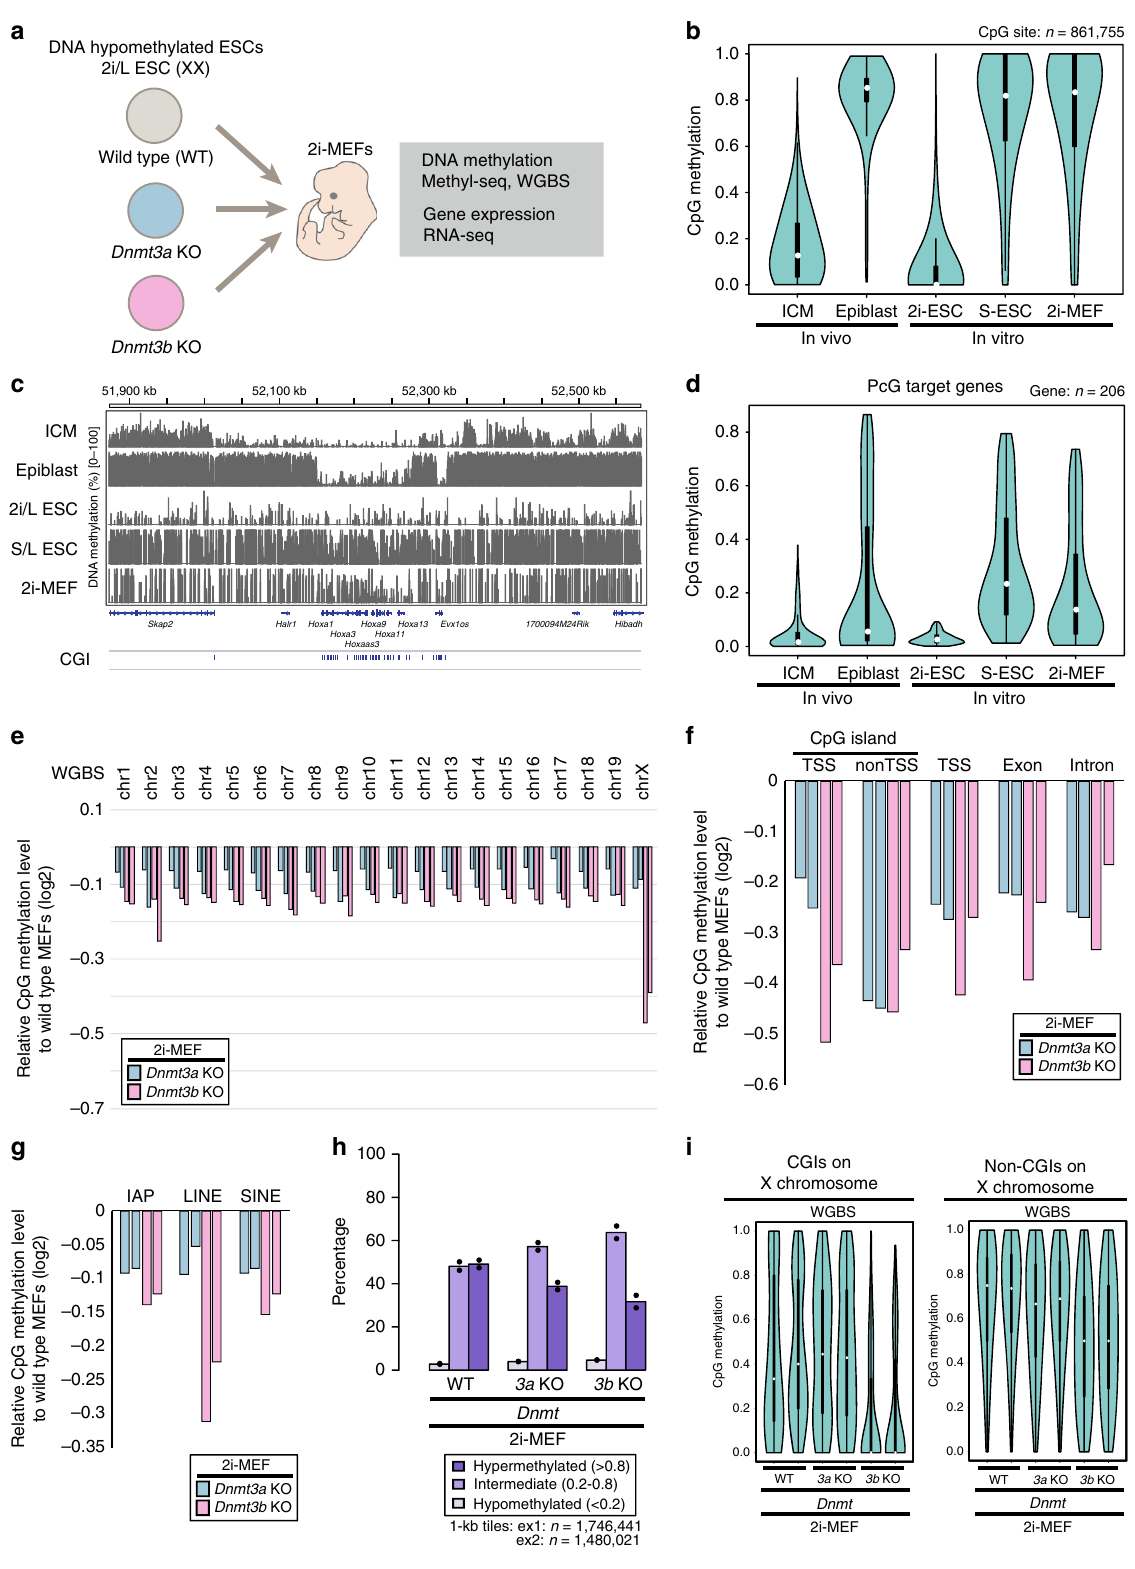
(4308 and 7357 DMTs in Dnmt3a and Dnmt3b KO 2i-MEFs, respectively) (Fig. 2a and Supplementary Data 1). A small subset of DMTs ( n = 143) exhibited a modest reduction in DNA methylation in both Dnmt3a KO and Dnmt3b KO 2i-MEFs, suggesting that these loci are suf fi ciently methylated only when DNMT3A and DNMT3B are both present (Fig. 2a and